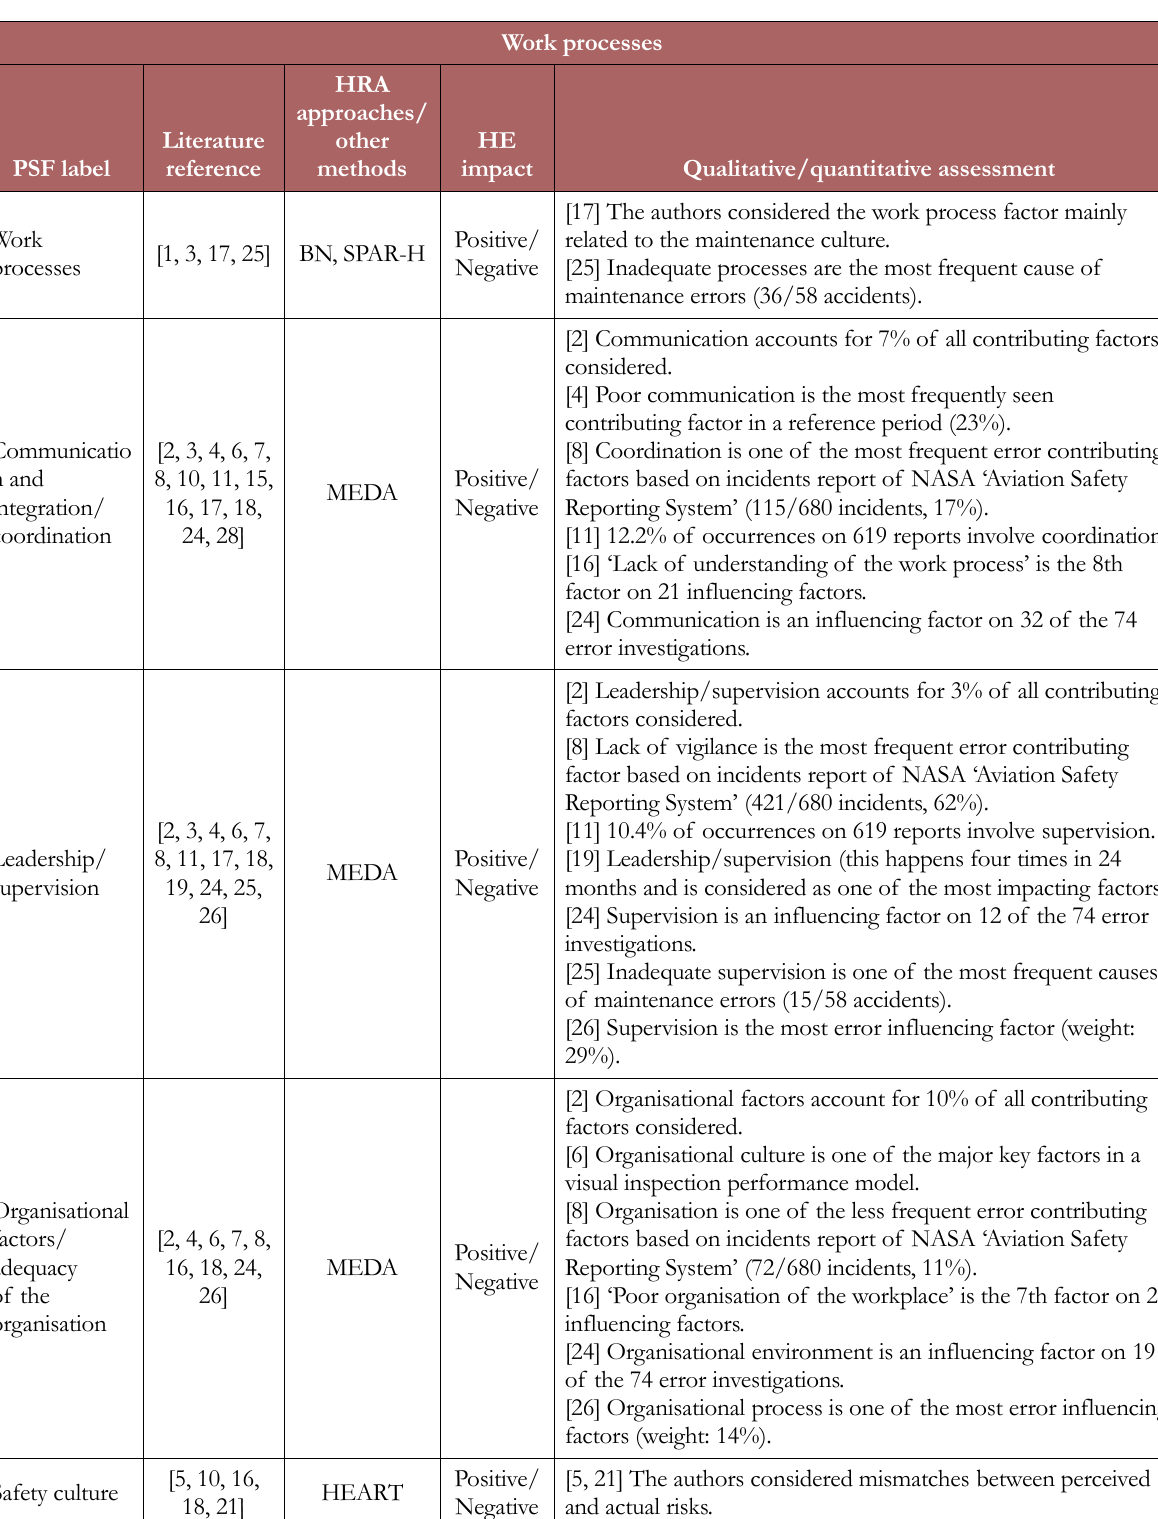
Table 6. Taxonomy of maintenance PSFs: work processes